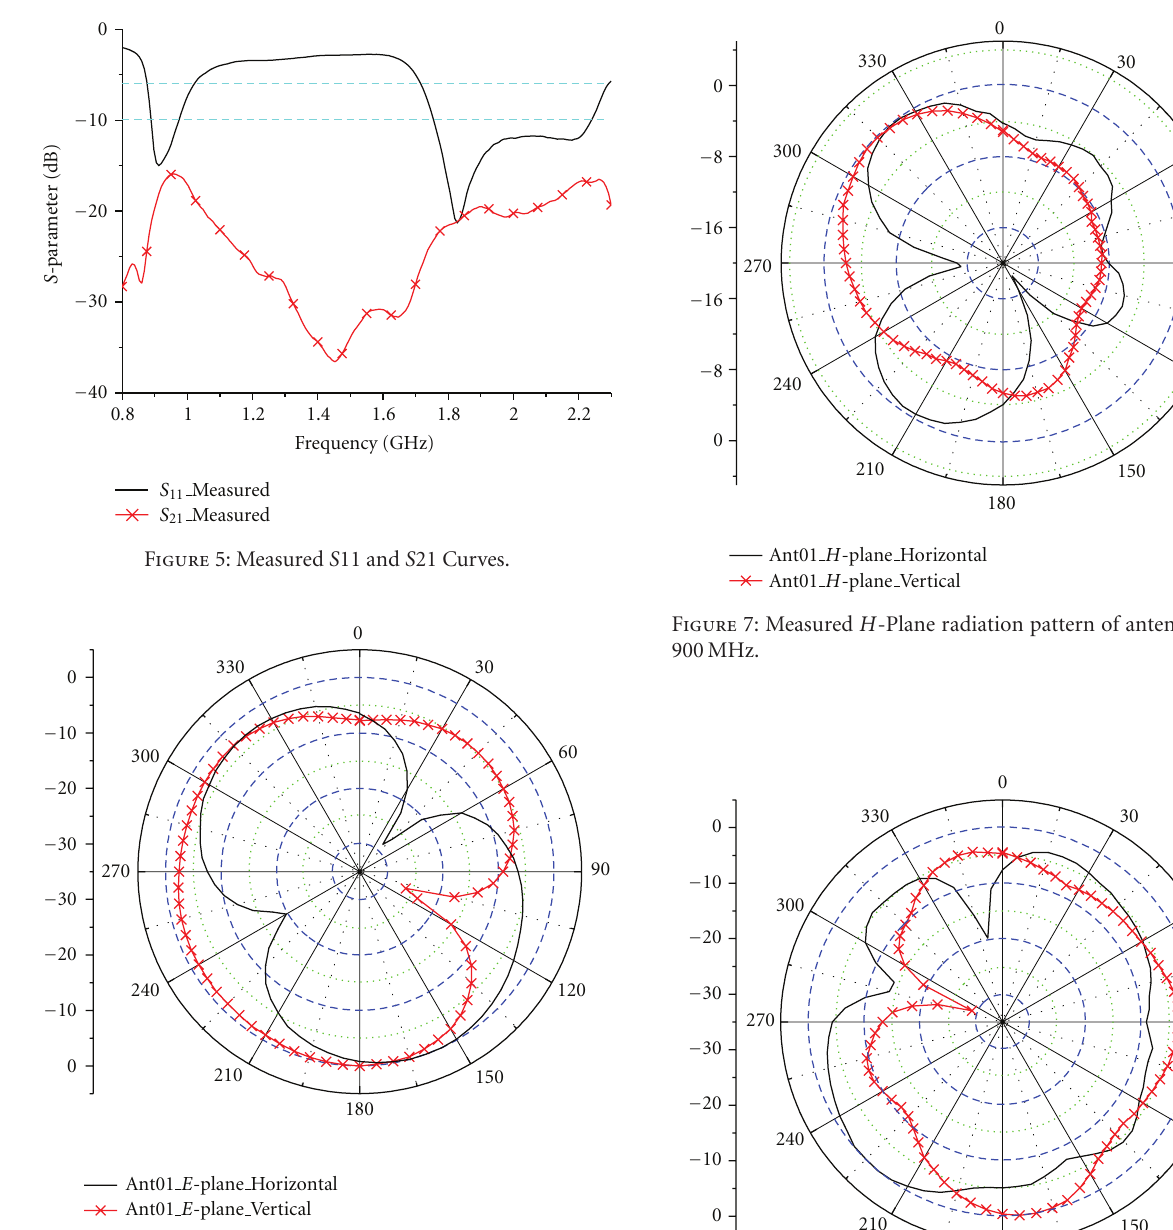
Figure 6: Measured E -Plane radiation pattern of antenna no. 1 at 900MHz.